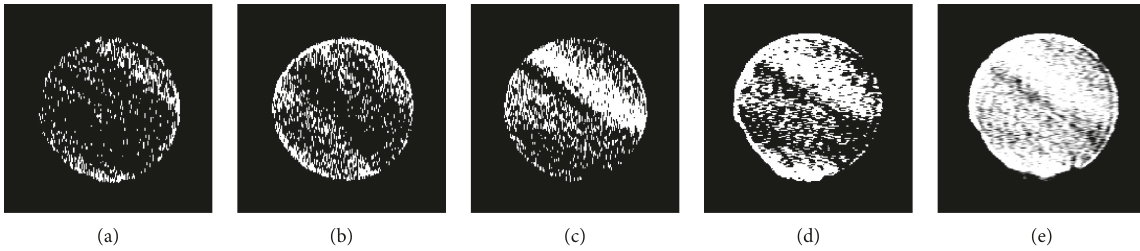
Figure 9: MRI of sandstone which underwent coupled effect of acid erosion (pH � 2.8) and recurrent F-Tcycling. (a) 0 F-Tcycles, (b) 10 F-T cycles, (c) 20 F-T cycles, (d) 30 F-T cycles, and (e) 40 F-T